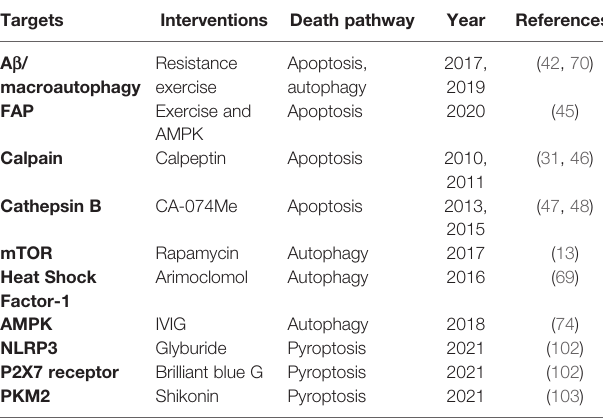
TABLE 2 | Possible therapeutic targets for